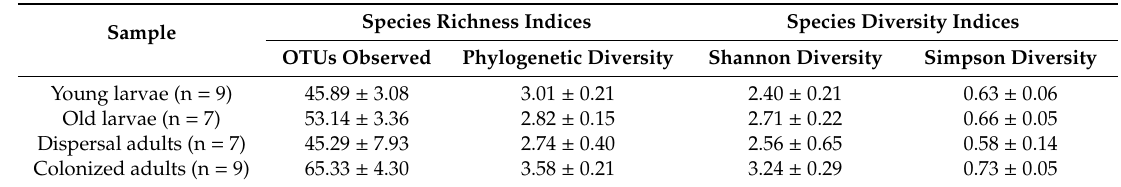
Table 1. Richness and diversity estimation (mean ± SEM) of the bacterial community in the gut at di ff erent life stages of Dendroctonus valens